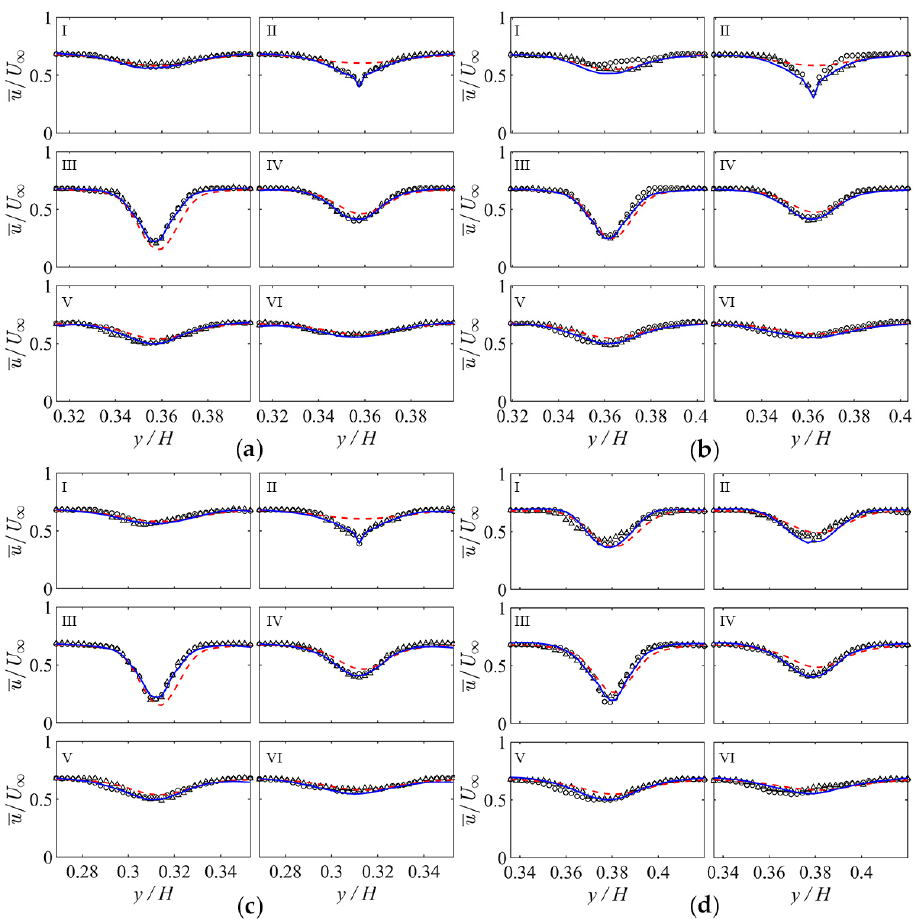
Figure 16. Velocity profiles along the spanwise direction at I, II, III, IV, V, and VI in Figure 14. ( a ) wind turbine 2 in the north-east case; ( b ) wind turbine 3 in the south case; ( c ) wind turbine 3 in the south-west case; ( d ) wind turbine 1 in the west case. (–) LES, (- -) Analytical model, ( ∆ ) CNN, and ( ⚬ ) CNN with data augmentation. To overcome the location sensitivity problem, we used the data augmentation technique. In this approach, instead of having a fixed location, the subdomains around the turbines are randomly moved up to 5 𝐷 upwind. We also increase the size of training samples by a factor of five. Using this approach, the training samples contain the turbines and their wakes which are randomly scattered in each subdomain. The training and validation results of the CNN trained using the data augmentation technique (CNN DA ) are depicted in Figures 11–16. The velocity deficits in the upwind wakes of the south and west cases are predicted more accurately in comparison to the results without data augmentation (Figure 15b,d, and I in Figure 16b,d). However, the discrepancies of the velocities around the turbines are still large in Figure 15b,d, because in these cases, the interaction with upwind turbine’s wake is stronger than the training case.